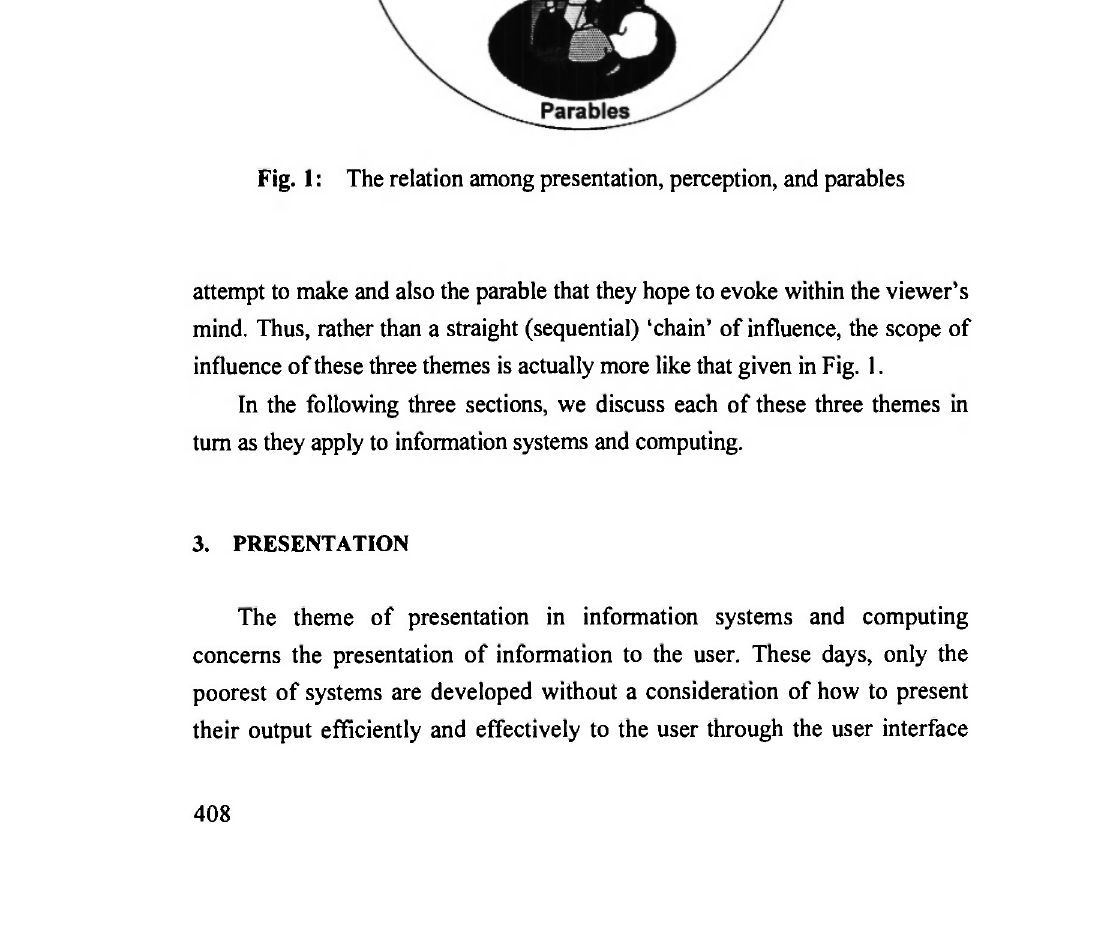
Fig. 1: The relation among presentation, perception, and